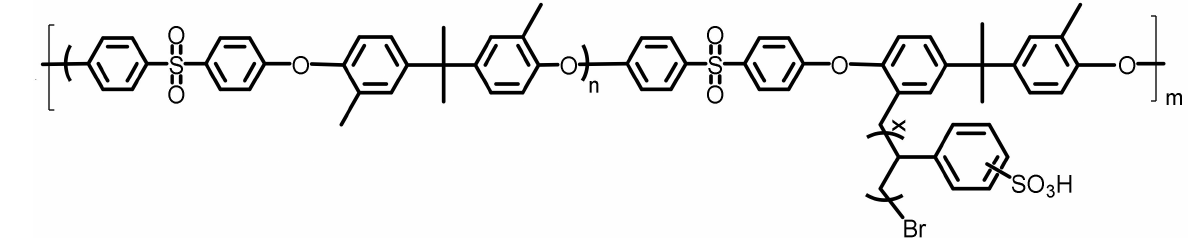
Figure 1. Chemical structure of the simulated SPAES